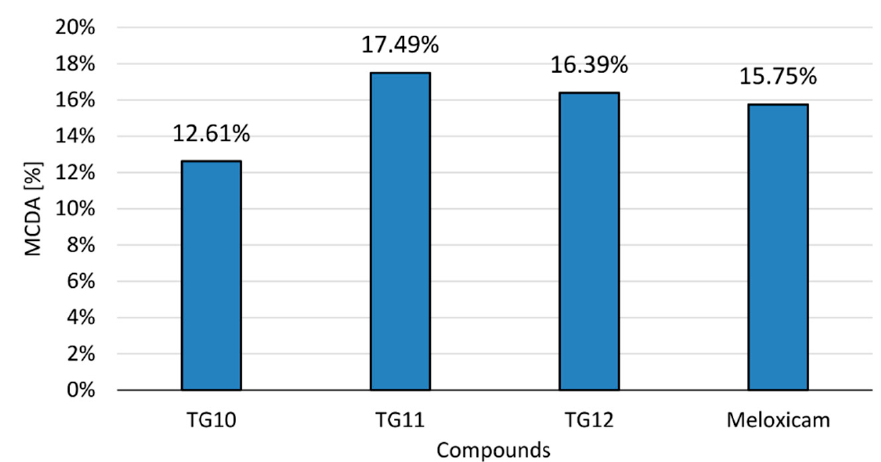
Figure 6. Multiple-criteria decision analysis (MCDA) of the anti-inflammatory effect of the tested compounds; MCDA was calculated based on the results of the cyclooxygenase inhibition assay and all in vitro tests on human chondrocytes that were performed.